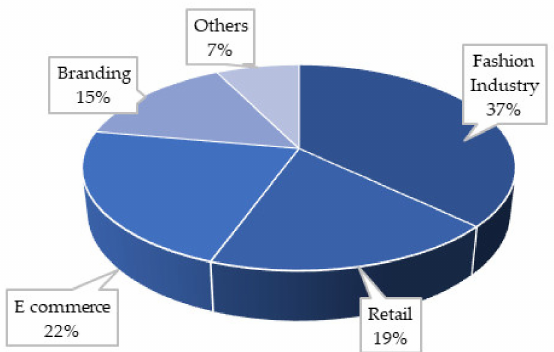
Figure 8. Distribution of the different apparel sectors identified in the articles listed in Table 3, selected by the search criteria related to text mining and apparel